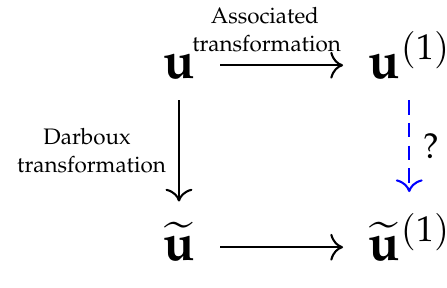
Figure 1. Structure of Problem